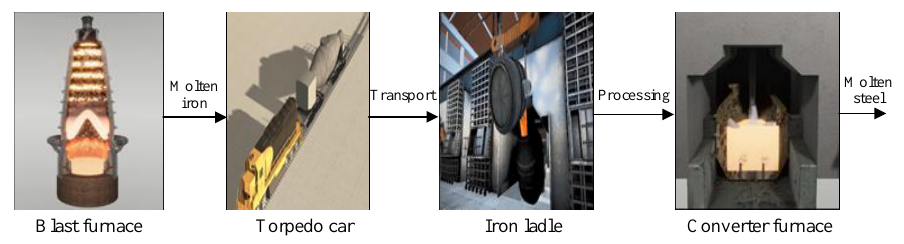
Figure 1. Smelting process of the iron and steel production.